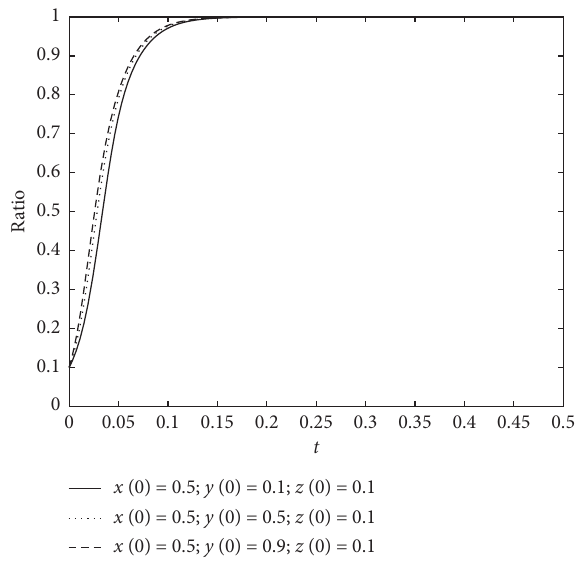
Figure 5: Different initial proportions of influence among gamers regarding the evolution of the platform.